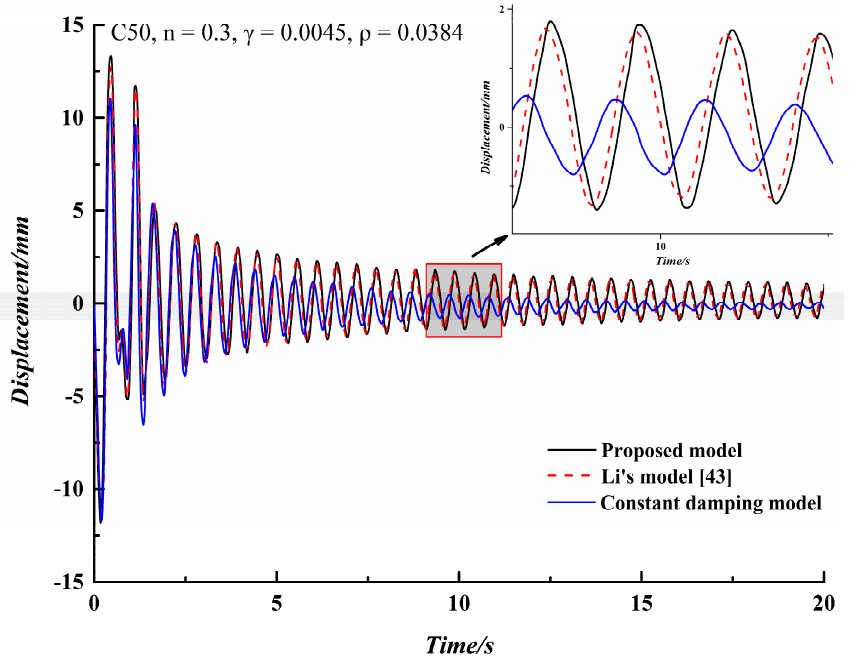
Figure 9. The column head displacement response of FRP-C RC columns with circular section under biaxial harmonic load (C50, n = 0.3, γ = 0.0045, ρ = 0.0384).